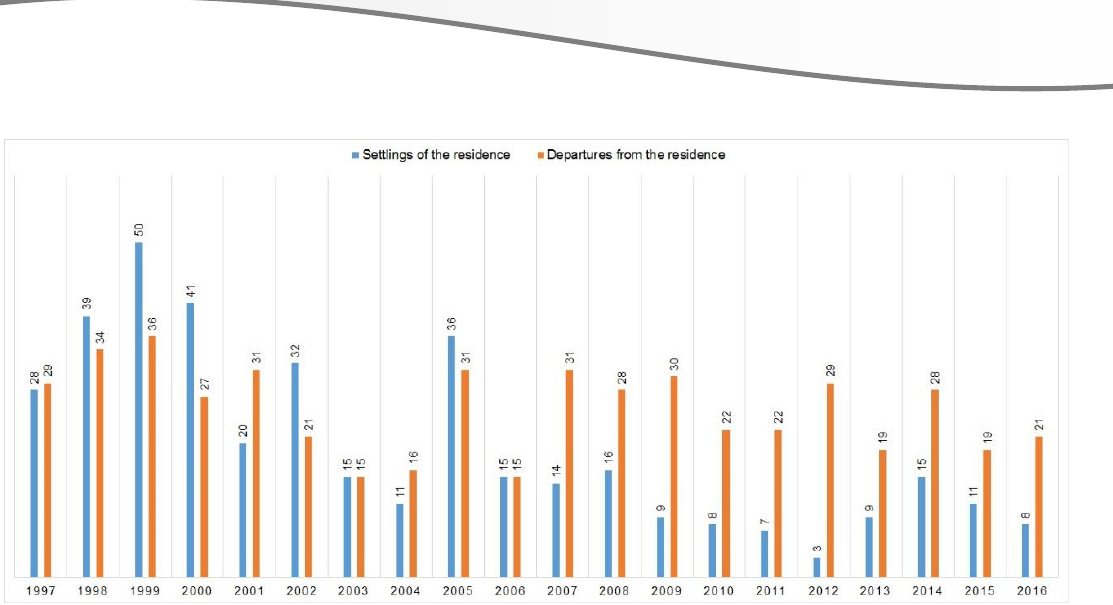
Figure 6: Changes of permanent residence -